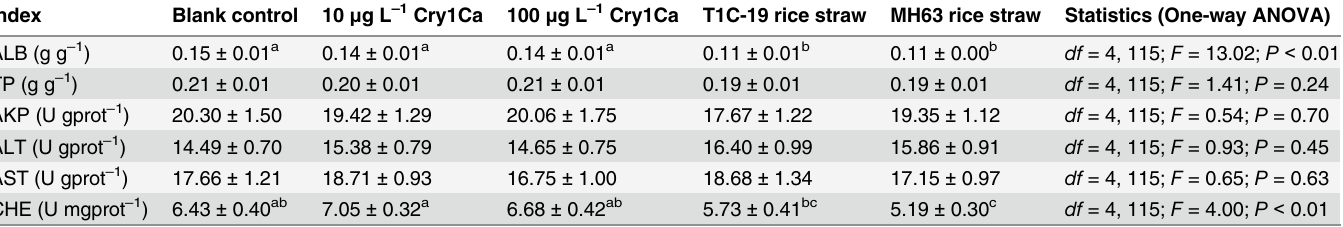
Table 4. Protein and enzyme activity in livers of Xenopus laevis tadpoles exposed to purified Cry1Ca, transgenic cry1Ca rice (T1C-19) straw and non-transformed isoline (MH63) straw (n = 24).